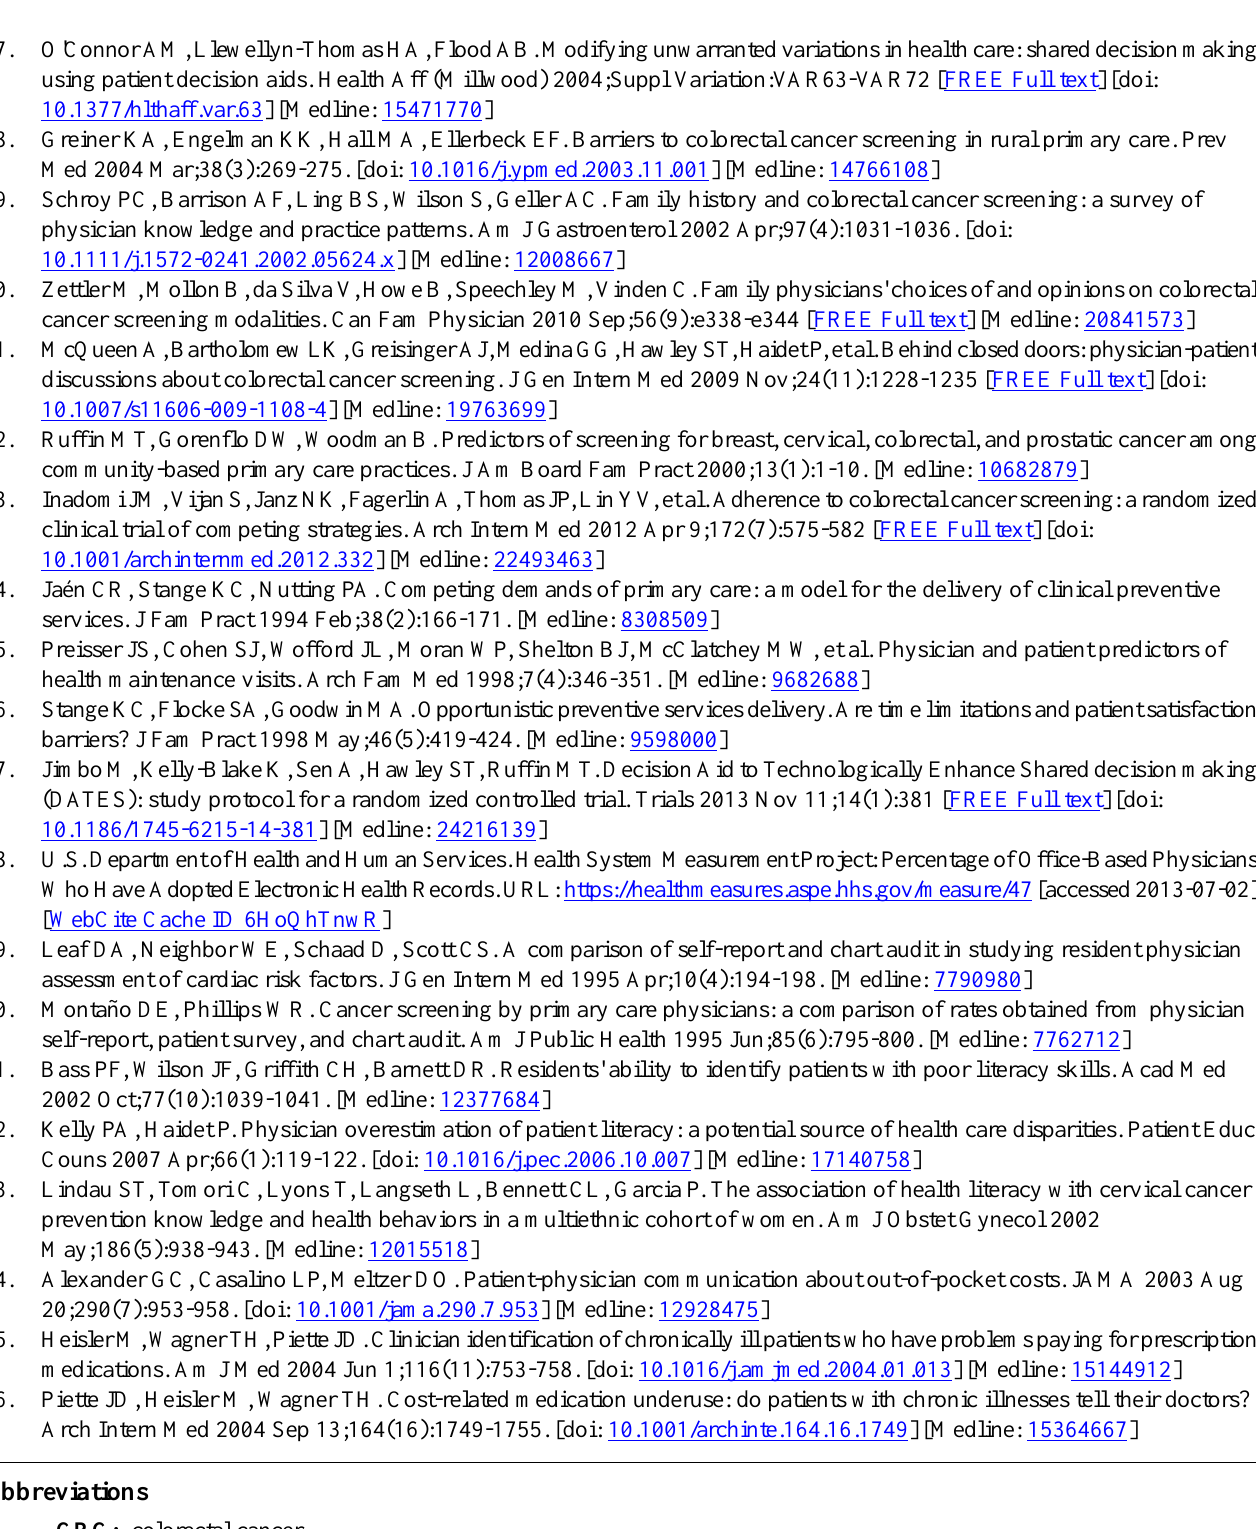
Abbreviations CRC: colorectal cancer EHR: electronic health record FOBT: fecal occult blood test PI: principal